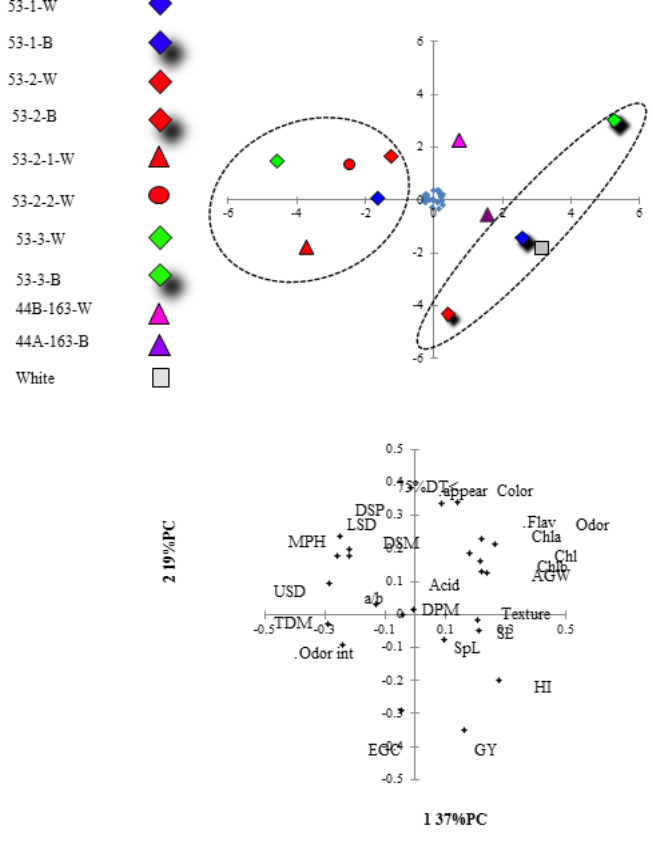
Figure 3. Principal component analysis (PCA) (based on correlation matrix) of continuous plant traits: TDM (Total Dry Matter),GY (Grain Yield), HI (Harvest Index), EGC (Early Ground Cover), LSD (Lower Stem width), USD (Upper stem width), Chla / gFW (Chlorophyll a), Chlb / gFW (Chlorophyll b), Chl / gFW (Total Chlorophyll), Chl a / b ratio, DSP (Days from Sowing to Panicle emergence), DPM (Days from Panicle emergence to Maturation), DSM (Days from Sowing to Maturation), AGW (Average Grain Weight), SL (Seed length), SpL (Spikelet length), MPH (Maximal Plot Height), and DT < 75% are recorded on the 11 lines. Elipses represent the grouping trend of the white / brown segregating lines. Biplot vectors are trait factor loadings for PC1 and PC2. The dots and labels in the bottom panel represent the strength (by distance from the axis center) and their direction relative to each other, each explain some of the total variance according to the di ff erent